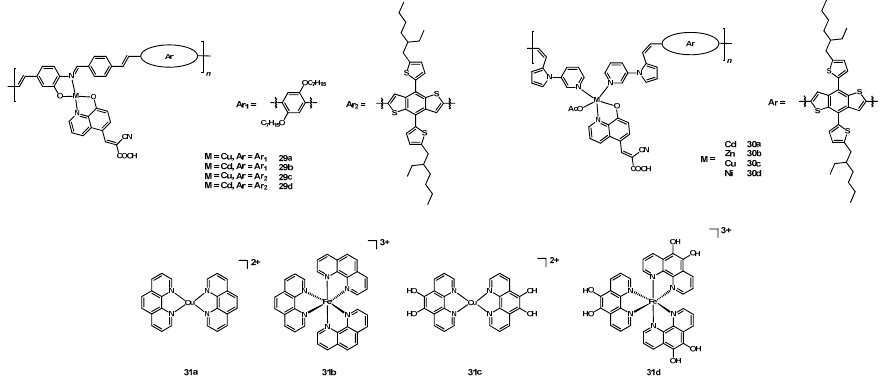
Figure 14. Structure of dyes 29a – d , 30a – d, and 31a – d